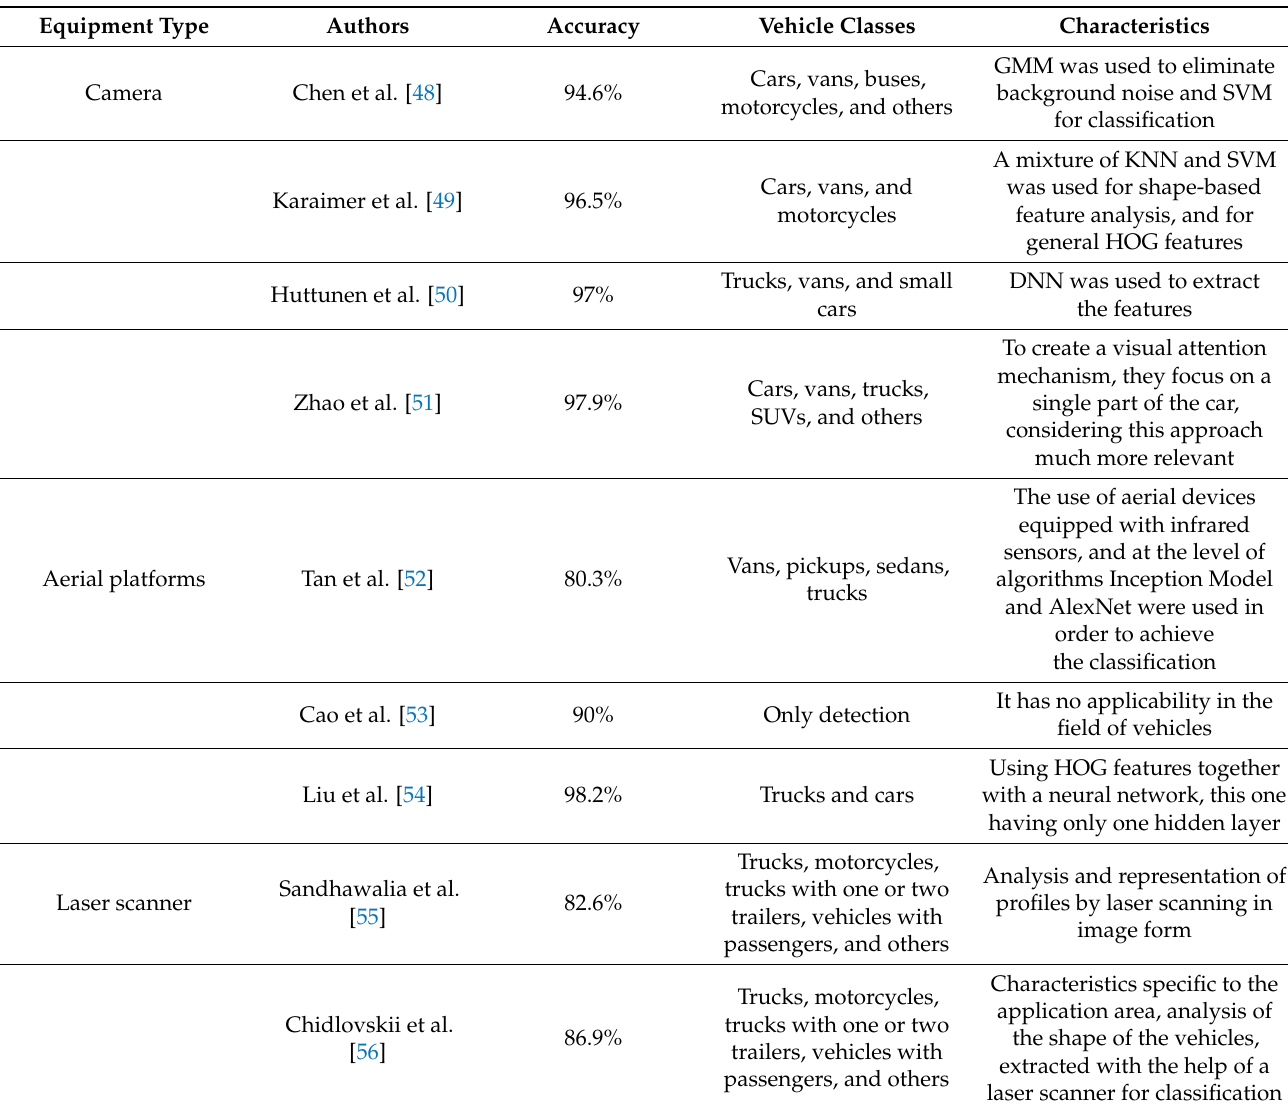
Table 2. Presentation of systems dedicated to the classification of vehicles at the over-roadway